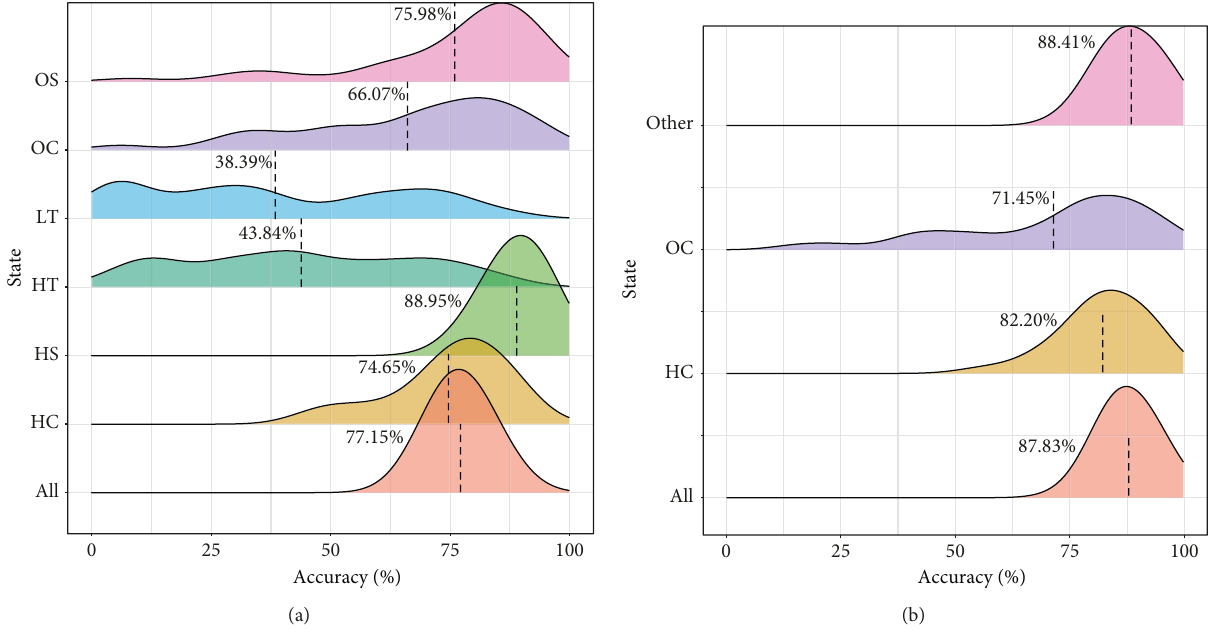
Figure 9: The prediction accuracy on different states. (a) Six types of state prediction. (b) Three types of state prediction.